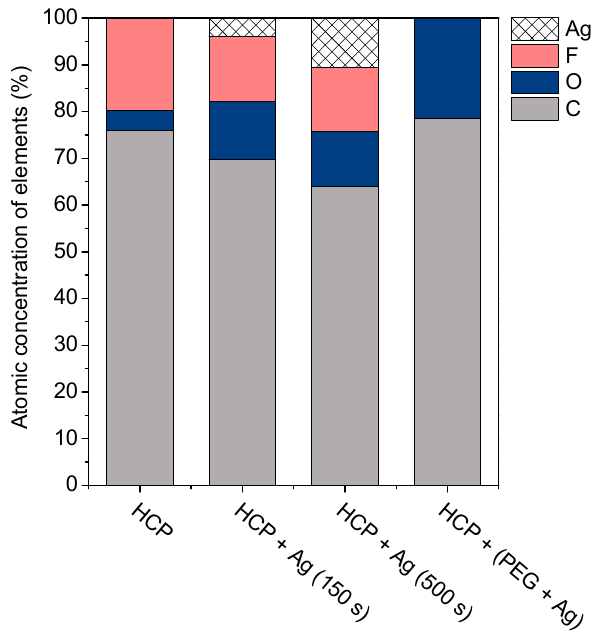
Figure 5. The atomic concentrations of Ag, F, O, and C elements (in at %) were determined using the energy-dispersive X-ray spectroscopy method for the sample with a honeycomb-like (HCP) structure, samples with Ag thin layers with the different time lengths of metal deposition (150 s and 500 s), and the sample containing polyethylene glycol (PEG) with sputtered Ag.